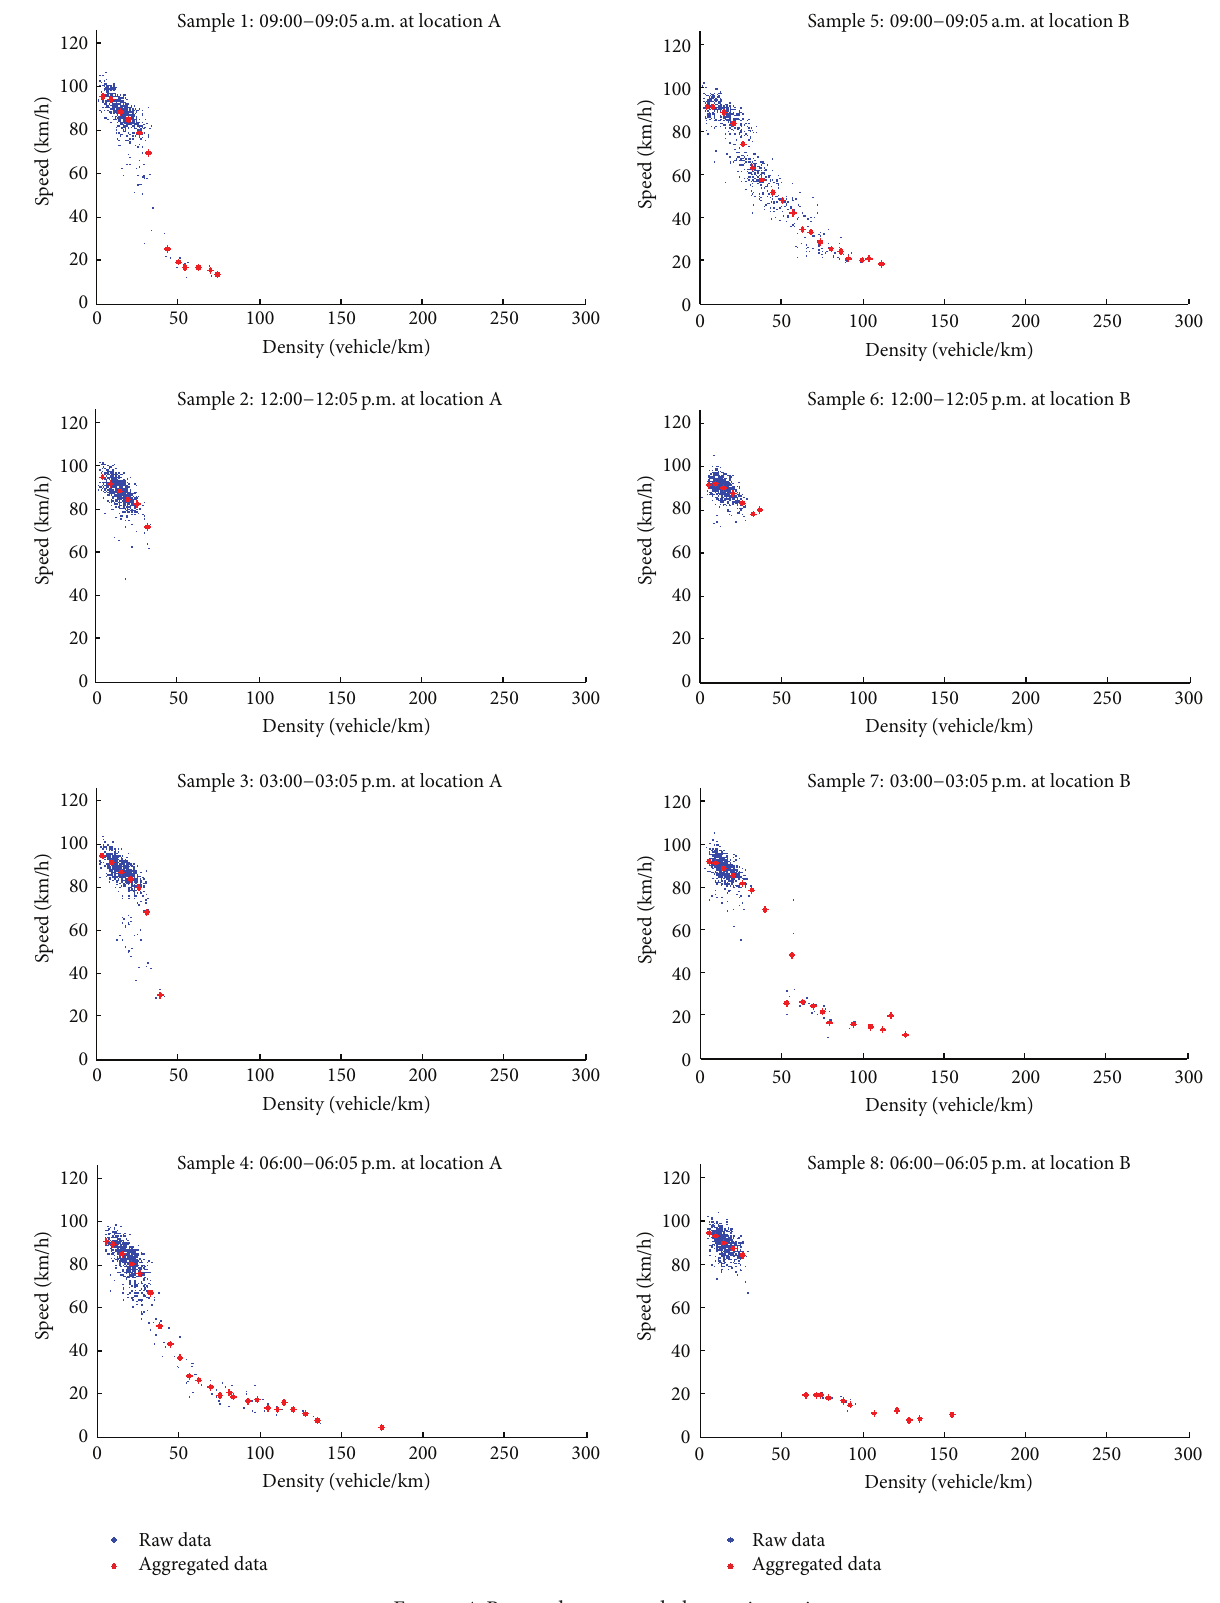
Figure 4: Raw and aggregated observation